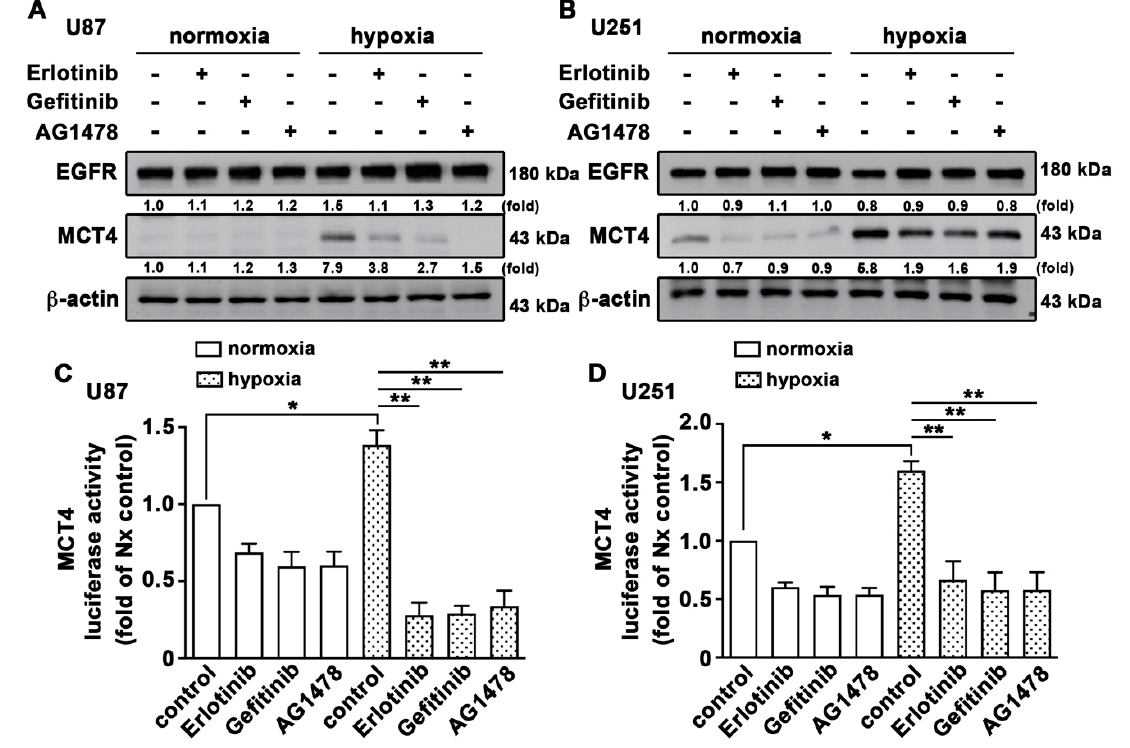
Figure 8. Activation of EGFR is involved in hypoxia-induced HIF-1 α and MCT4 expression in GBM. U87 ( A ) and U251 ( B ) cells were treated with EGFR inhibitors (50 nM erlotinib; 50 nM gefitinib; 10 µ M AG1478) for 30 min and were exposed to hypoxic conditions (1% O 2 ) for another 24 h. EGFR and MCT4 expression was determined using western blotting. U87 ( C ) and U251 ( D ) cells were transfected with MCT4 luciferase reporter plasmids for 24 h and were treated with EGFR inhibitors (50 nM erlotinib; 50 nM gefitinib; 10 µ M AG1478) for 30 min and were then exposed to hypoxic conditions (1% O 2 ) for another 24 h. Firefly luciferase activity was measured, and the results were normalized to renilla luciferase activity. Two-way ANOVA with a post-hoc Bonferroni test was used to examine the significance of the mean. * p < 0.05 compared with normoxia control group. ** p < 0.01 compared with the hypoxia-only group. Quantitative data are presented as the mean ± S.E.M. ( n =